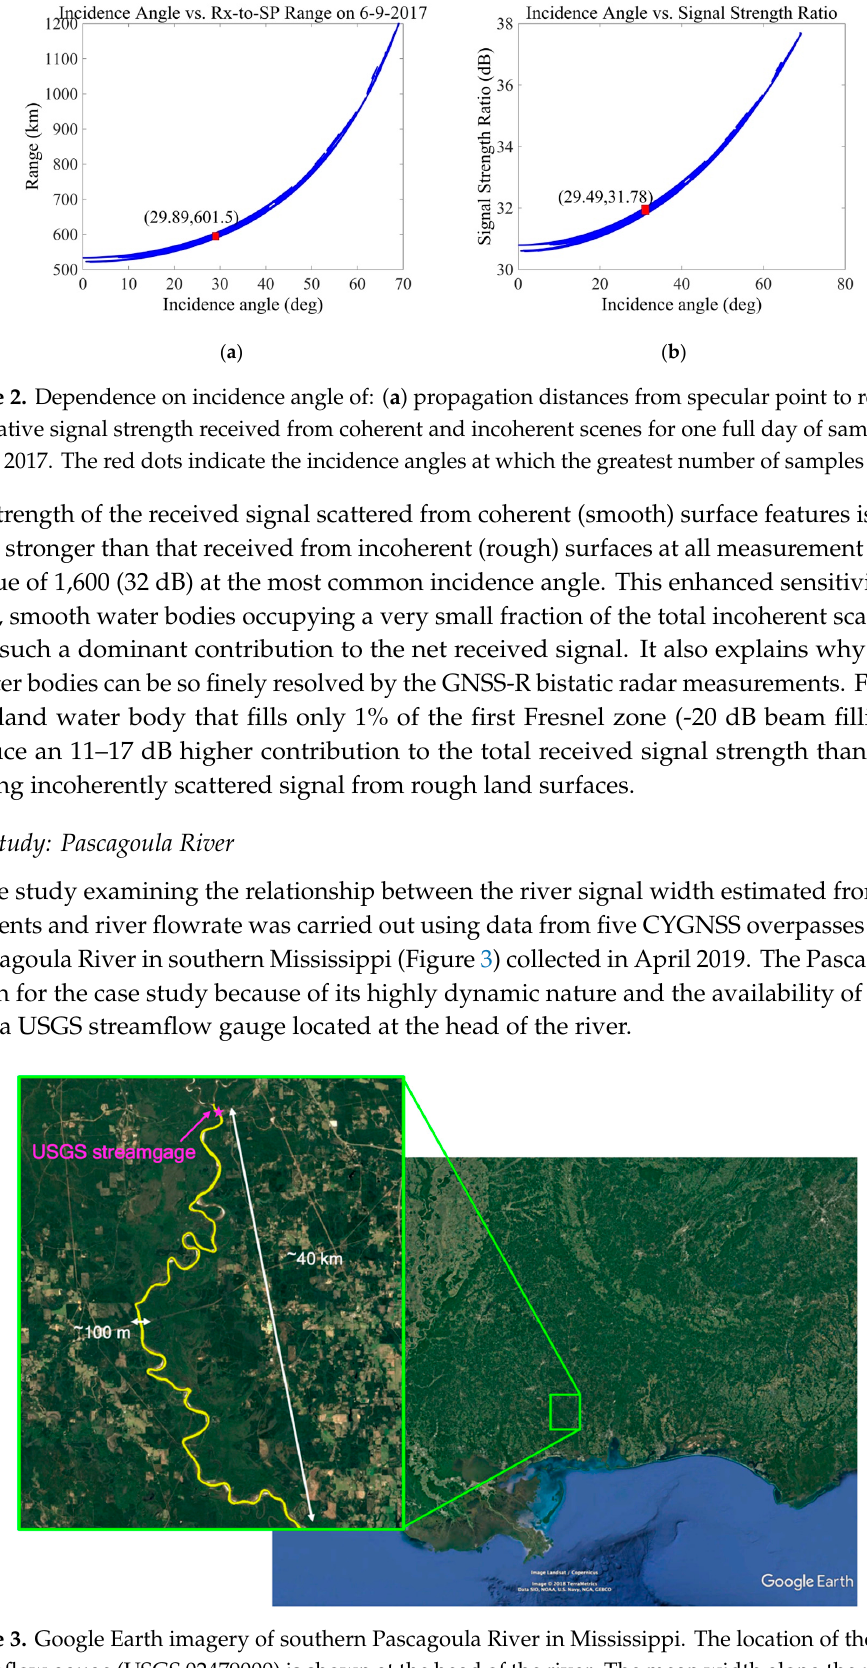
streamflow gauge (USGS 02479000) is shown at the head of the river. The mean width along the